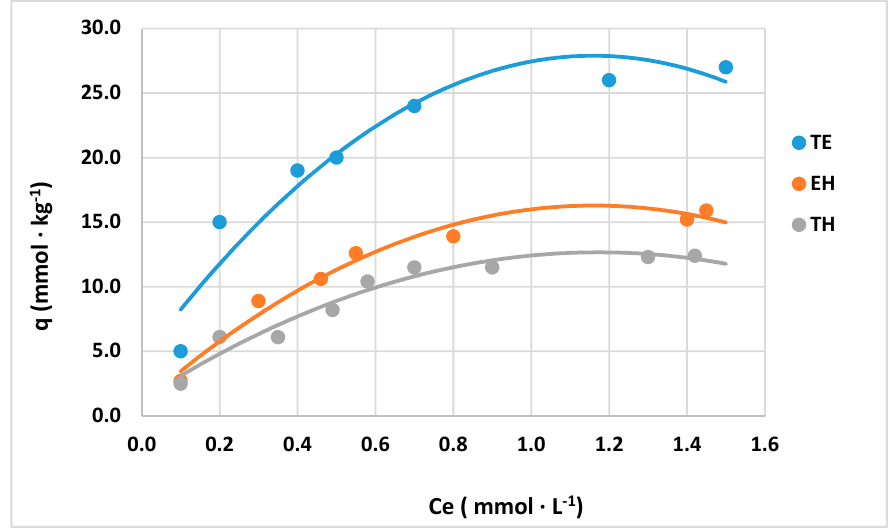
Figure 1. Tungstate adsorption isotherms in the investigated soils.